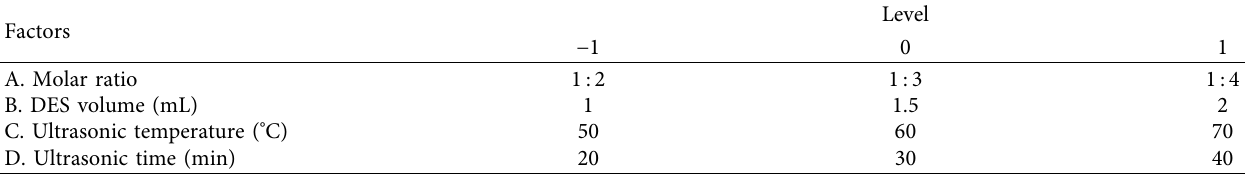
Table 3: Test factors and level design of response surface methodology.